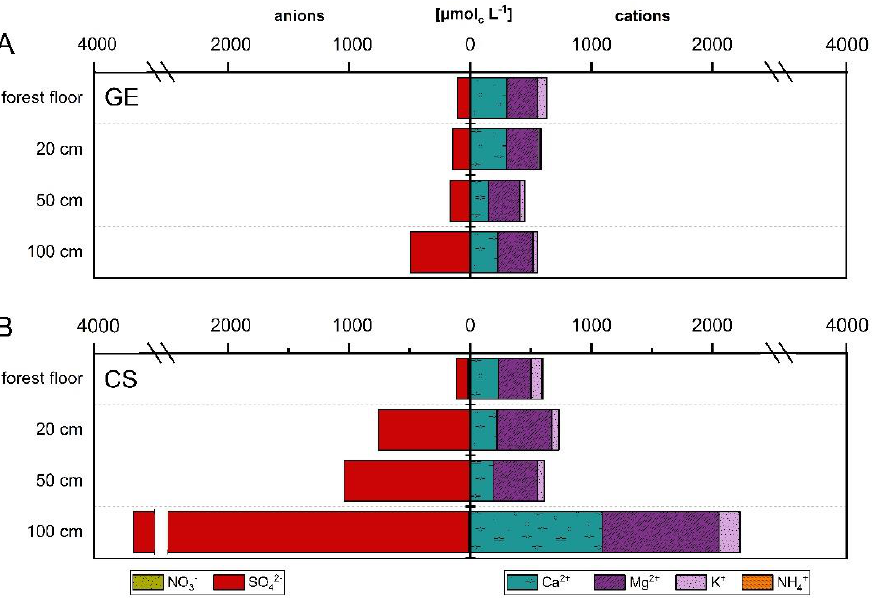
Figure 4. Depth patterns in macronutrient concentration ( µ mol c L − 1 ) of forest floor and soil solution (20 cm, 50 cm, 100 cm depth) divided into anions (NO 3 − , SO 42 − ) and cations (NH 4+ , K + , Ca 2+ , Mg 2+ ) at the plot-pair GE/CS ICP. ( A ): GE; ( B ): CS. The rooting zone of main tree species covers a depth of 70 cm (GE) and 55 cm (CS) [47]. Nitrate (GE: < 3.5 µ mol c L − 1 ; CS: < 17.2 µ mol c L − 1 ) and ammonium (GE: < 7.4 µ mol c L − 1 ; CS: < 12.6 µ mol c L − 1 ) concentrations are low and not feasible.